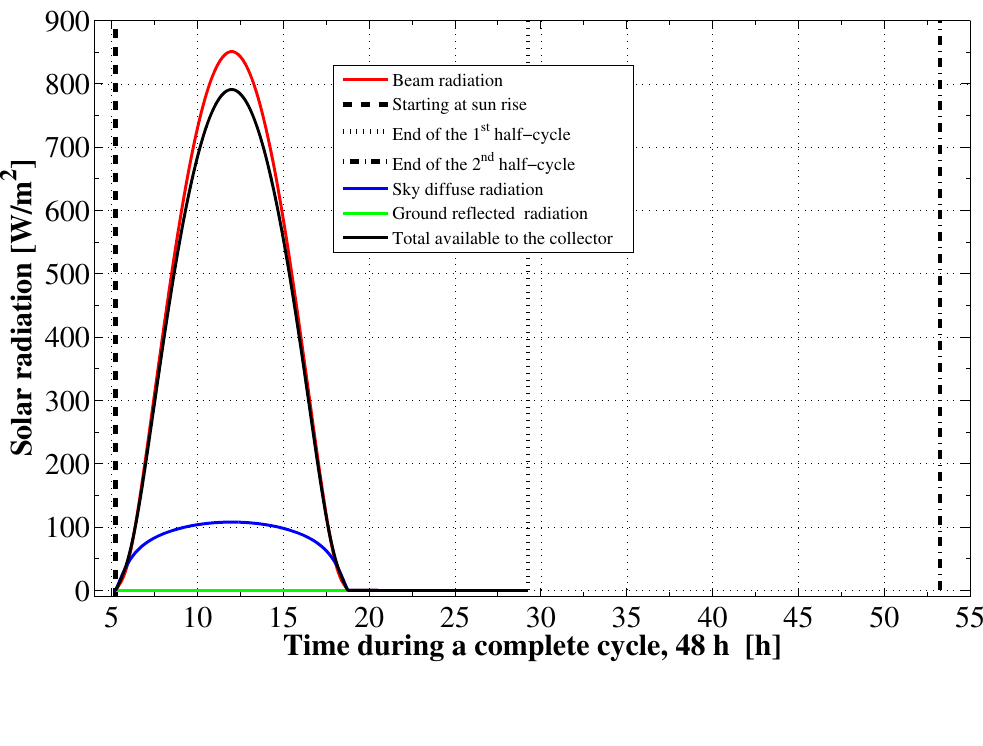
Figure 1. Components of the solar radiation incident on the collector, as determined by the ASHRAE clear sky model for Riyadh (24.7 ◦ N, 46.7 ◦ E), 1 July 2013.